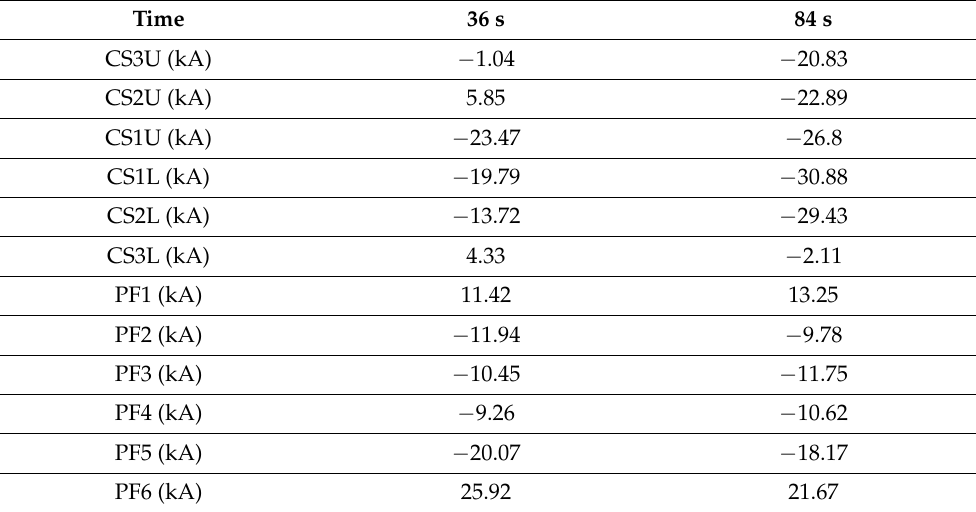
Figure 6. Time evolution of voltages for the DTT flat-top phase: ( a ) CS voltages; ( b ) PF voltages. Table 5. Time evolution of CS/PF currents of the SN flat-top phase.